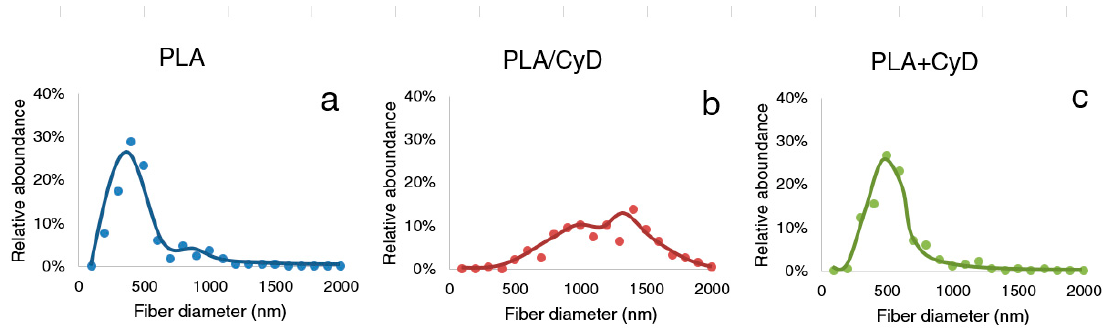
Figure 3. Fiber diameter distribution for ( a ) PLA, ( b ) PLA / CyD, and ( c ) PLA + CyD electrospun nano- fibers.